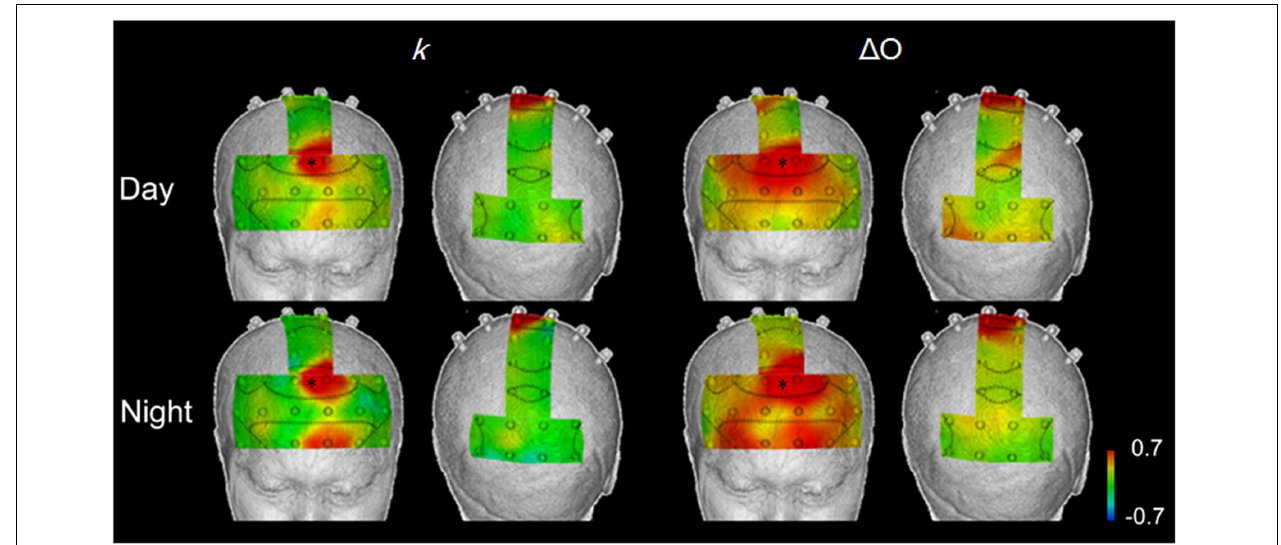
FIGURE 6 | Correlation maps showing interregional correlations between responses in the supplementary eye field ( ∗ ), where there were high correlations with vehicle acceleration during in both daytime and